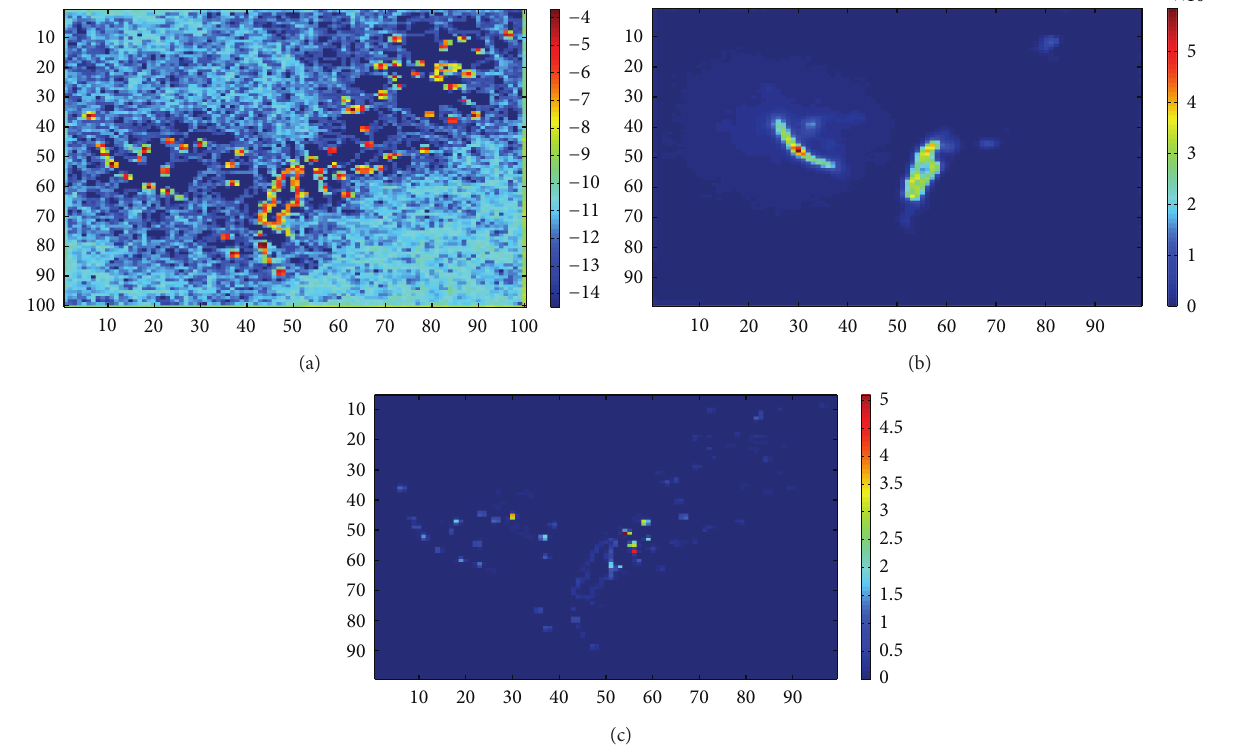
)) Logarithm of Figure 12: Comparison of the microscopic prediction and macroscopic model for the map 𝑀 at 𝑡 = 140 h. (a) ( log (𝑃 micro the probability distribution obtained simulating 200 agents for 30,000 seconds. Logarithmic distribution is used to highlight the states with ) Probability distribution obtained with Fokker-Planck equation. (c) Product of both distributions, decreasing the low probability. (b) ( 𝑃 macro × 𝑃 1/2 importance of high values in the microscopic simulation (specifically 𝑃 macro micro